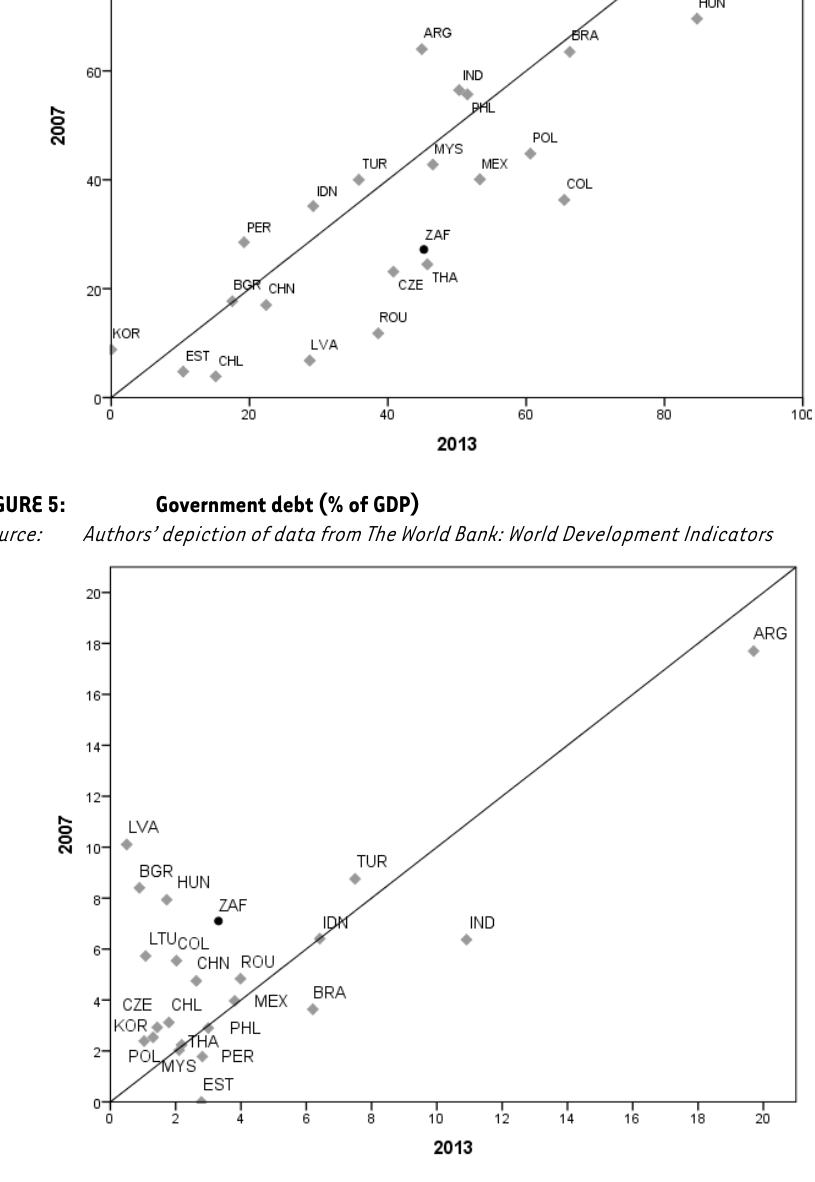
FIGURE 6: Inflation (annual %) Source: Authors’ depiction of data from The World Bank: World Development